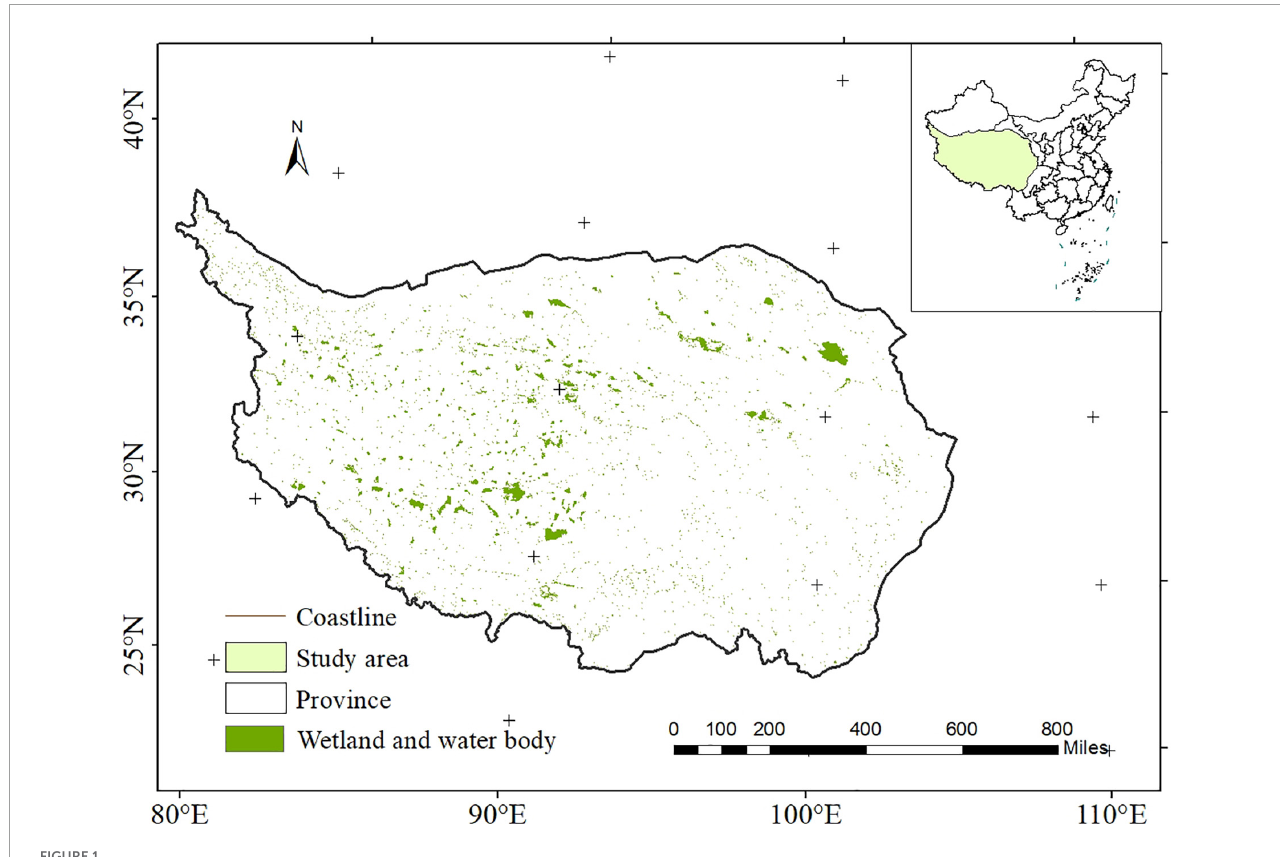
FIGURE1 Location of the study